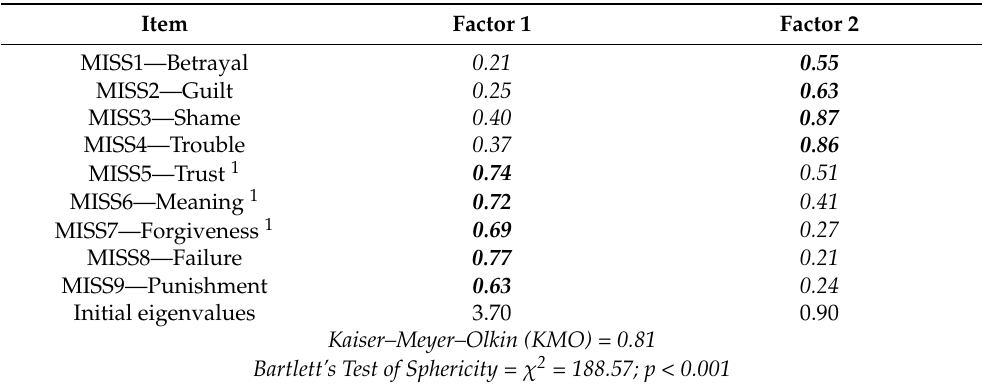
Table 6. Structural matrix factor loadings of principal components analysis with promax rotation for 9 items of G-MISS-HP (n 2 = 78; second half of the sample).